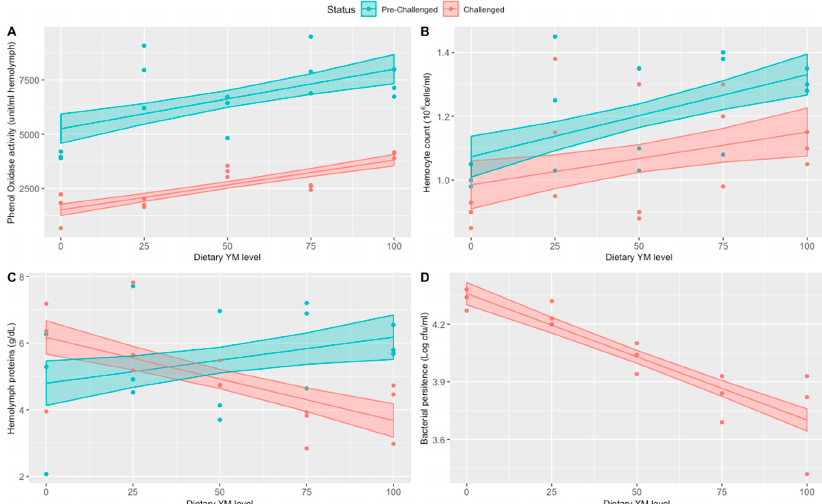
Figure 2. Immune status of the shrimp before and after bacterial challenge. ( A ) Phenoloxidase ( B ) Total hemocyte counts ( C ) hemolymph protein ( D ) persistent bacterial numbers in hemolymph 3 h after the bacterial challenge. Confidence bands for each fitted line correspond to one SEM (n = 3).